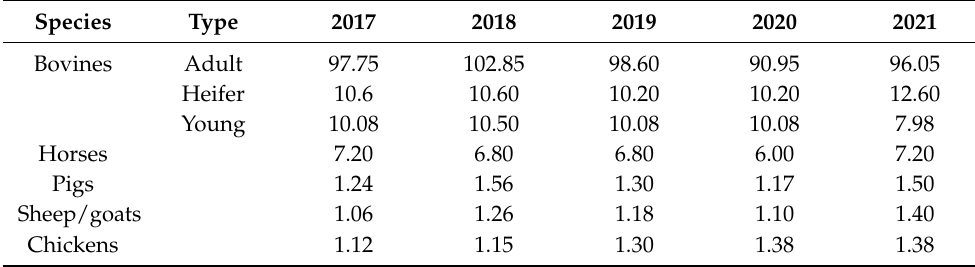
Table 3. Calculated biomass (in 1000 tonnes) of domestic livestock in Bhutan.